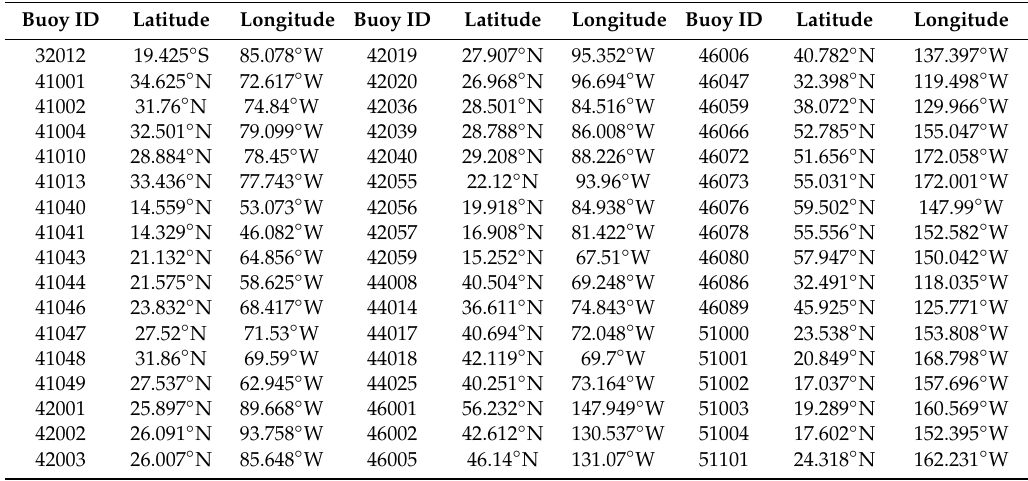
Table A1. The locations of the buoys used in this